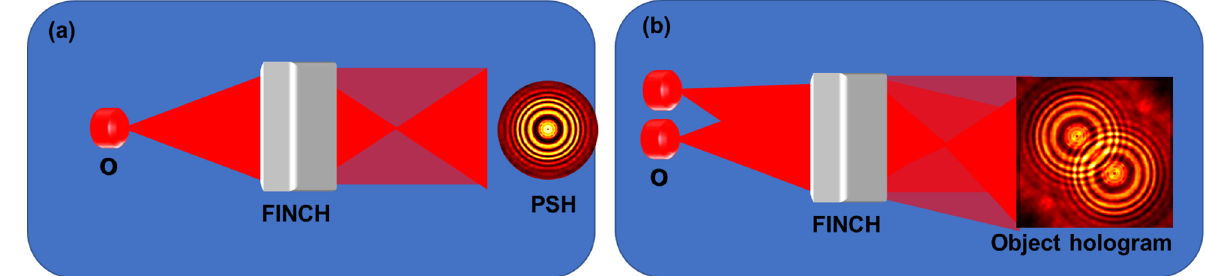
Figure 9. ( a ) Fresnel hologram obtained for a point and ( b ) Fresnel hologram obtained for two points.